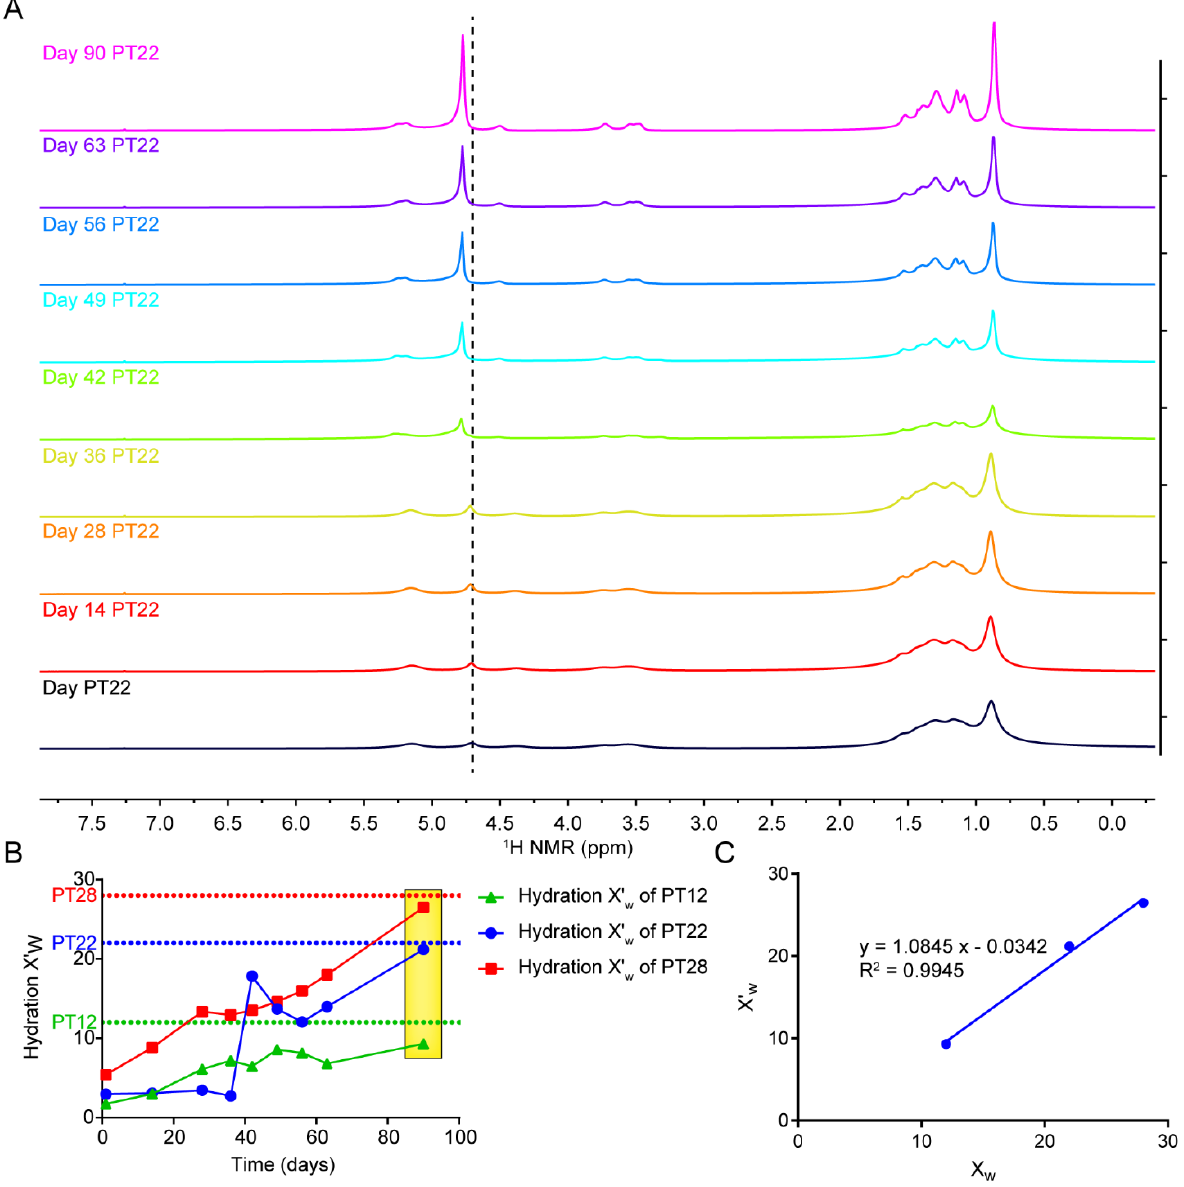
Figure 3. The hydration of phytantriol/water LCP. ( A ) 1 H NMR spectra of PT22 changed with time. ( B ) hydration level of PT12, PT22 and PT28 changed with time (on the day 1, 14, 28, 36, 42, 49, 56, 63 and 90). ( C ) The relationship between actual hydration and theoretical value on day 90.